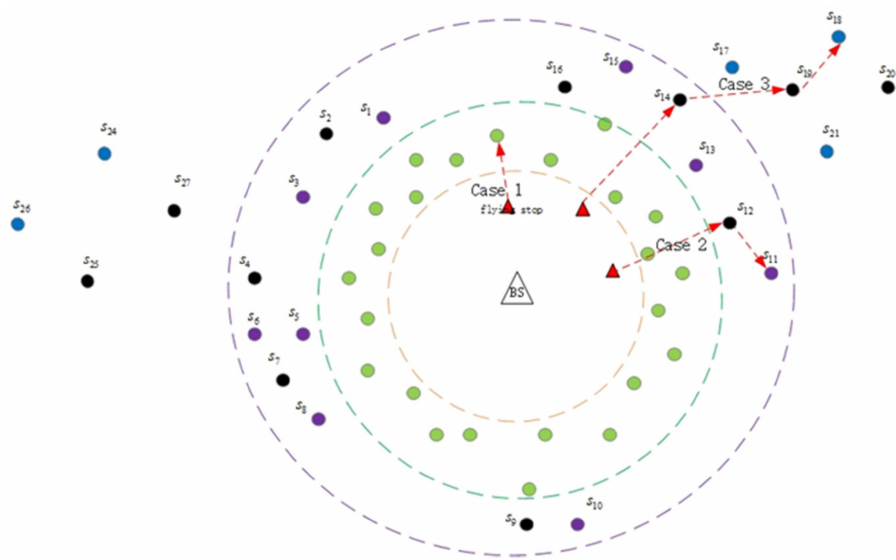
Figure 6. Determining the flying stops for drones based on three cases of the target sensor